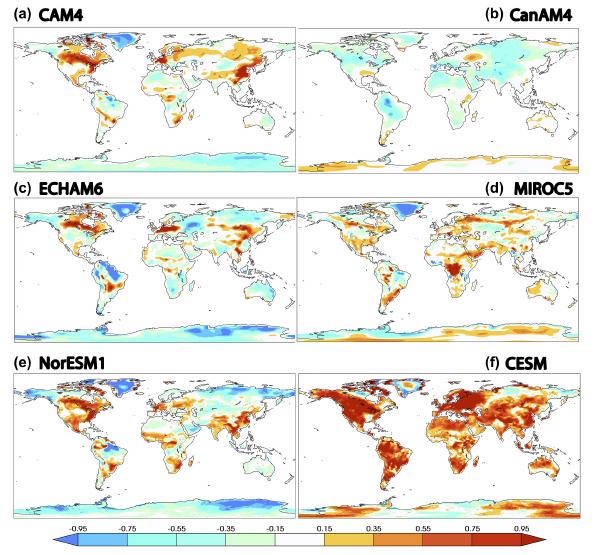
Figure 6. Differences between changes in 20-year return values of TX3x and changes in hot season average temperatures ( ◦ C) in the 2.0 ◦ C HAPPI simulations. (a) CAM4. (b) CanAM4. (c) ECHAM6. (d) MIROC5. (e) NorESM1. (f)